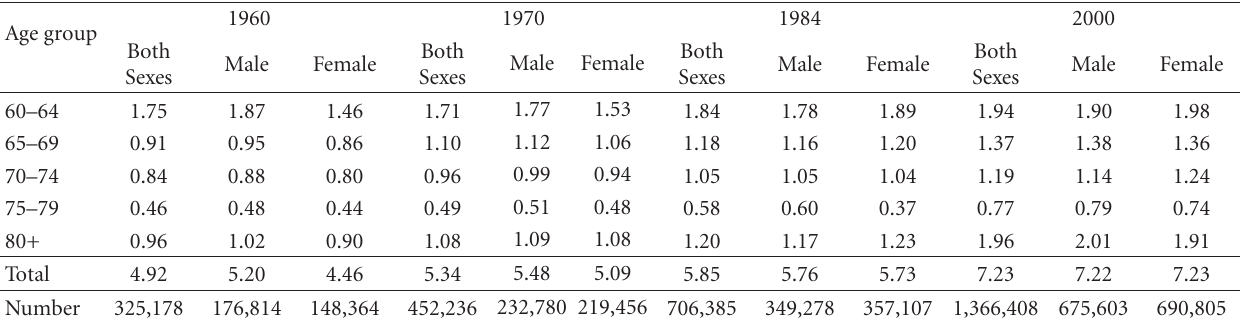
Table 2: Percentage distribution of Ghana’s elderly population by sex: 1960–2000.